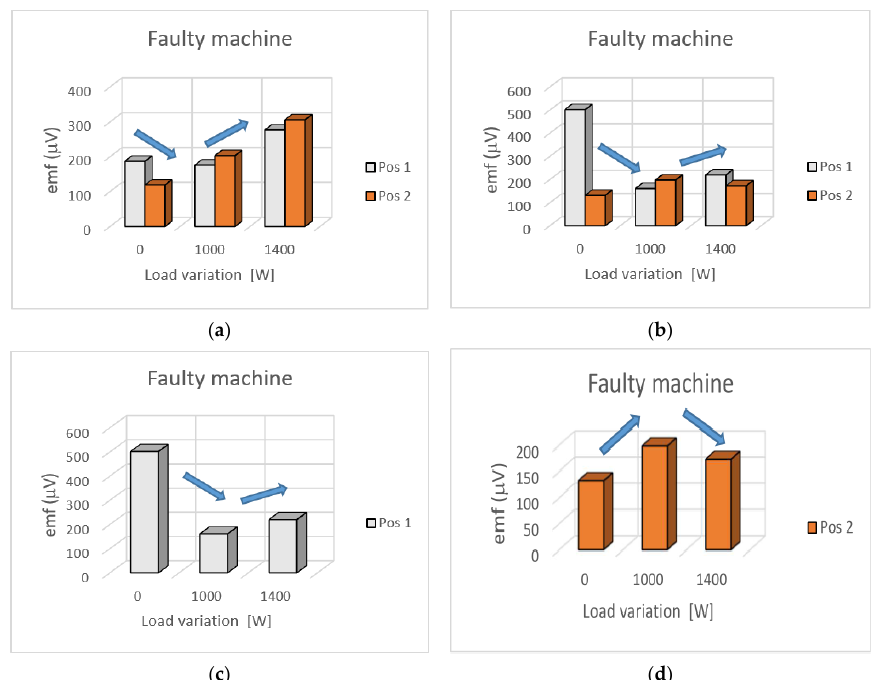
Figure 11. Harmonic components at 850 Hz under both measurement positions for faulty motor and load variation ( a ) short-circuit current Isc limited at 8.2 A, ( b ) short-circuit current limited at 15.3 A, ( c ) load variation for a sensor in position 1 and Isc = 15.3 A, ( d ) load variation for a sensor in position 2 and Isc = 15.3 A. Energies 2021 , 14 , x FOR PEER REVIEW